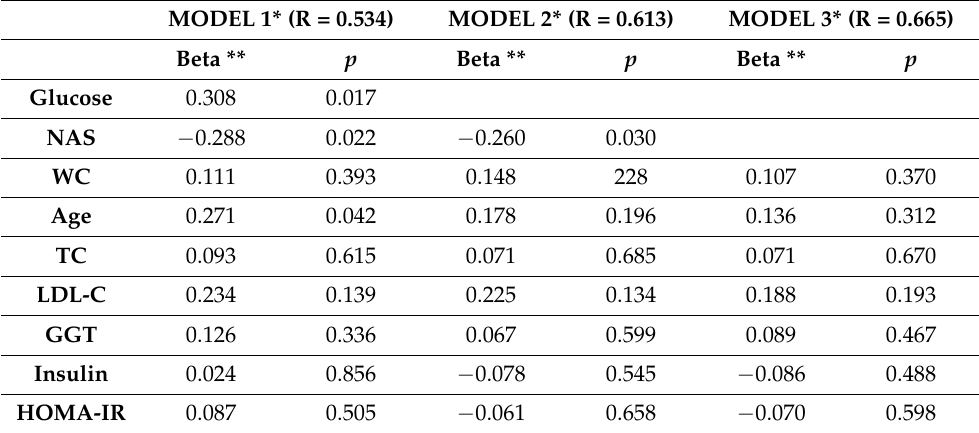
Table 2. Stepwise multiple regression test results depicting the independent predictors of serum betatrophin